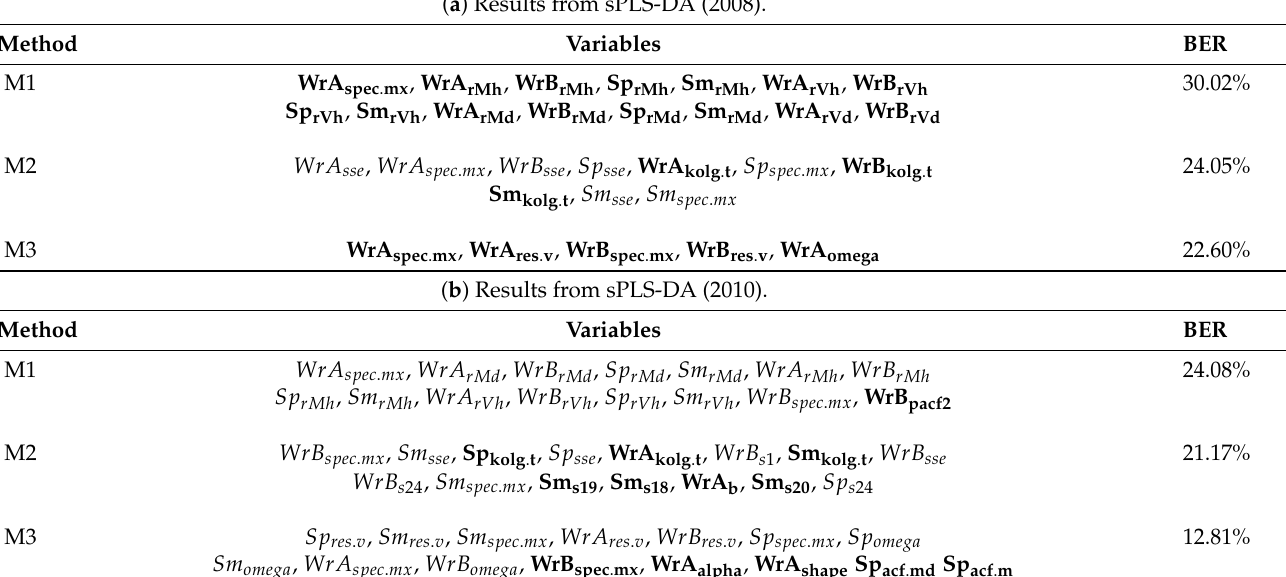
Table 1. Results from sPLS-DA (2008 and 2010): variables selected for the first component per method (M) for each period ( WrA stands for winter-A, WrB for winter-B, Sp for spring, and Sm for summer). With respect to the names of the selected classification variables, a prefix is used to indicate the period of the time series that was used to apply the three methods. For example, WrA was used as a prefix in the name of the classification variables to indicate the part of the time series where the variables came from. Thus, WrA rMh indicates that the variable rMh corresponds to period WrA. For each component, variables are ordered according to the absolute value of their loading weights, from highest to lowest. Variables with negative weights are highlighted in bold. The balanced classification error rate ( BER ) is indicated for the first component per